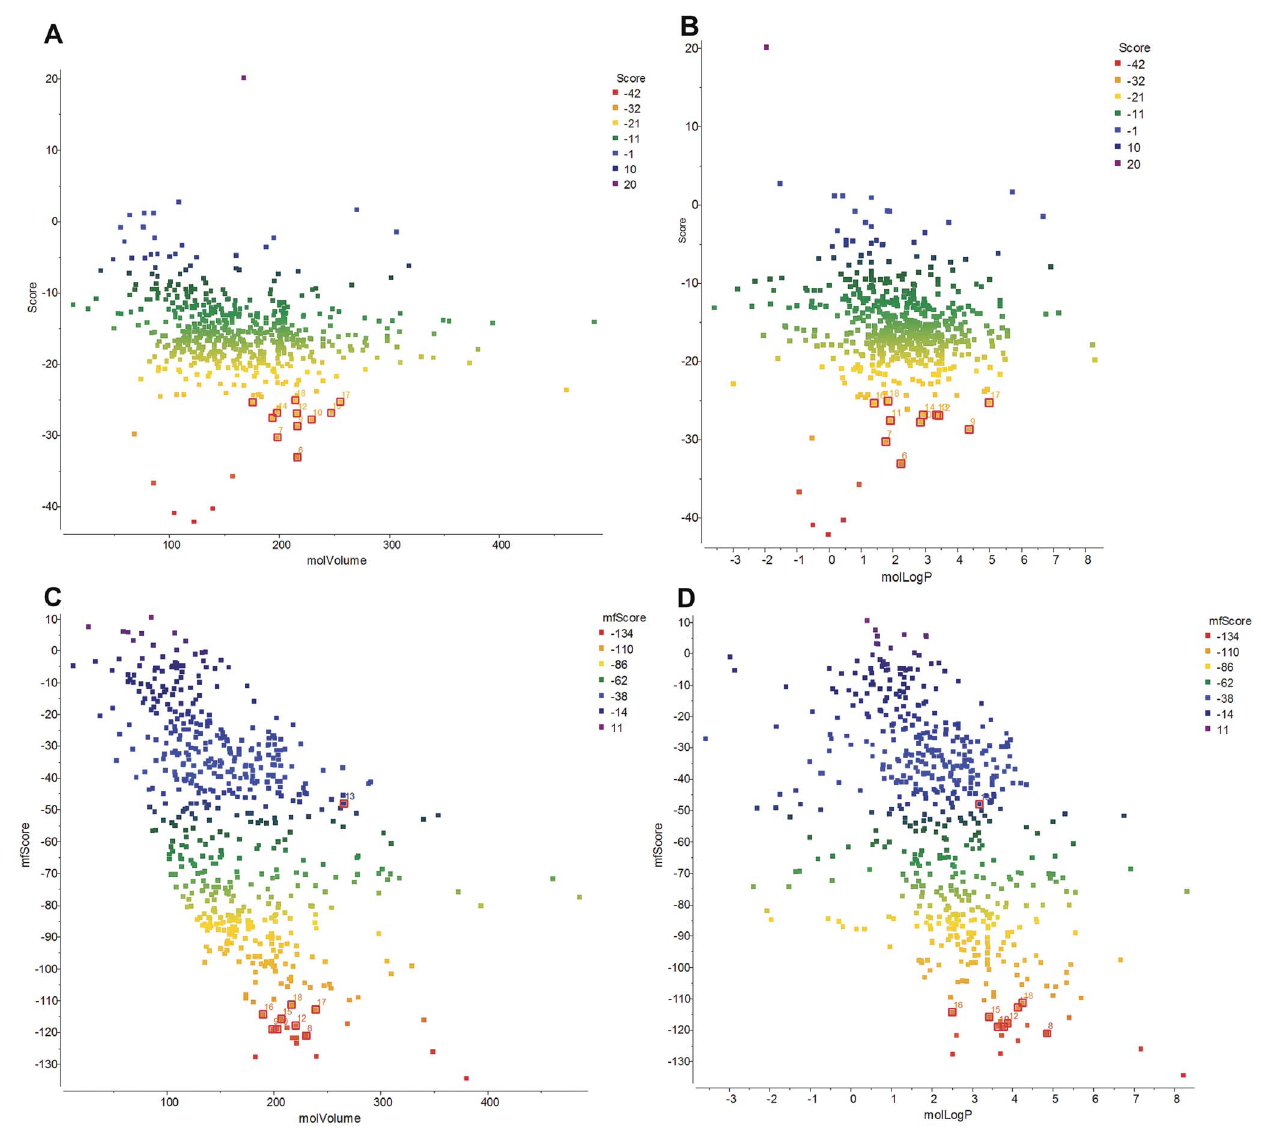
Figure 4. Clustering of the ligands based on their molecular properties. A. VLS dot plot of score values vs molecular volume. Compounds acting as ligands from the Table 1 are labeled. Color scheme represents scoring as indicated. B. VLS dot plot of score values vs log P for compounds from Table 1 are labeled. C. VLS dot plot of mfscore values vs molecular volume. Compounds acting as ligands from the Table 2 are labeled. D. VLS dot plot of score values vs log P for compounds from Table 2 are labeled.